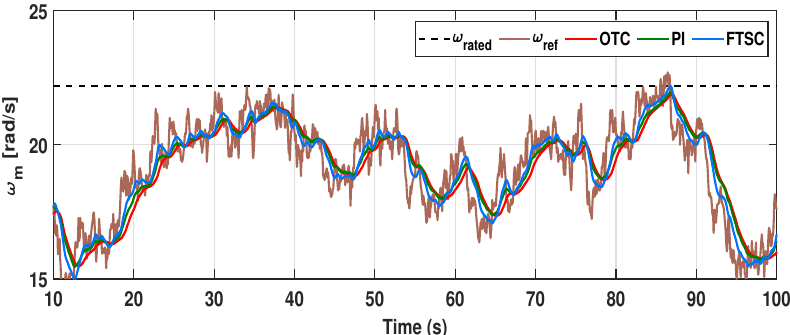
Figure 12. Dynamic response of rotor speed under proposed control scheme in comparison with OTC and PI controllers for varying wind profile case-I .